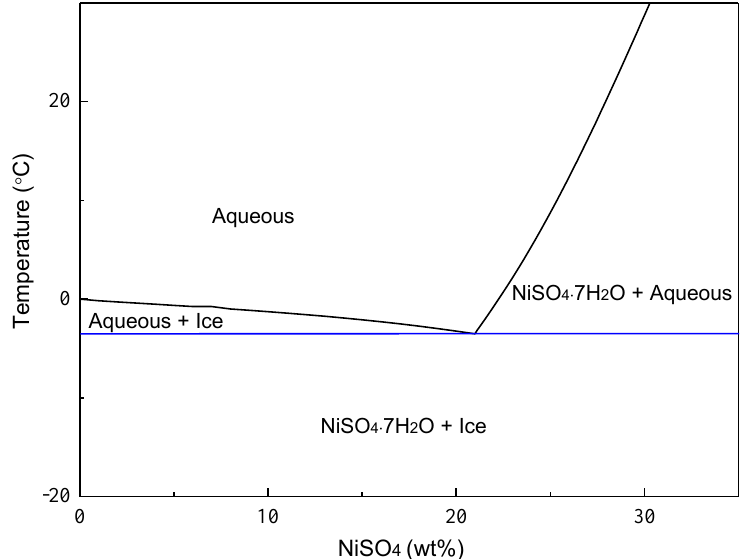
Figure 6. Binary phase diagram of the NiSO 4 -H 2 O system (solubility data based on literature reports [46,56]).